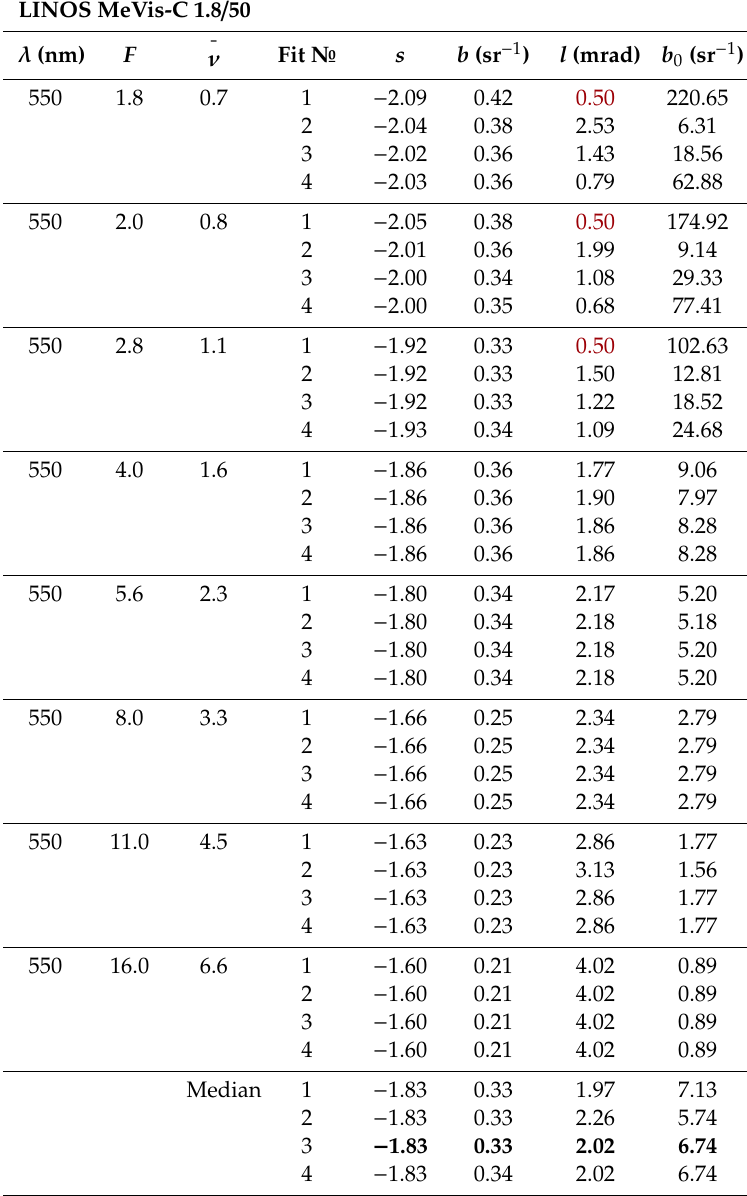
Table A4. Fit results for the lens LINOS MeVis-C 1.8 /